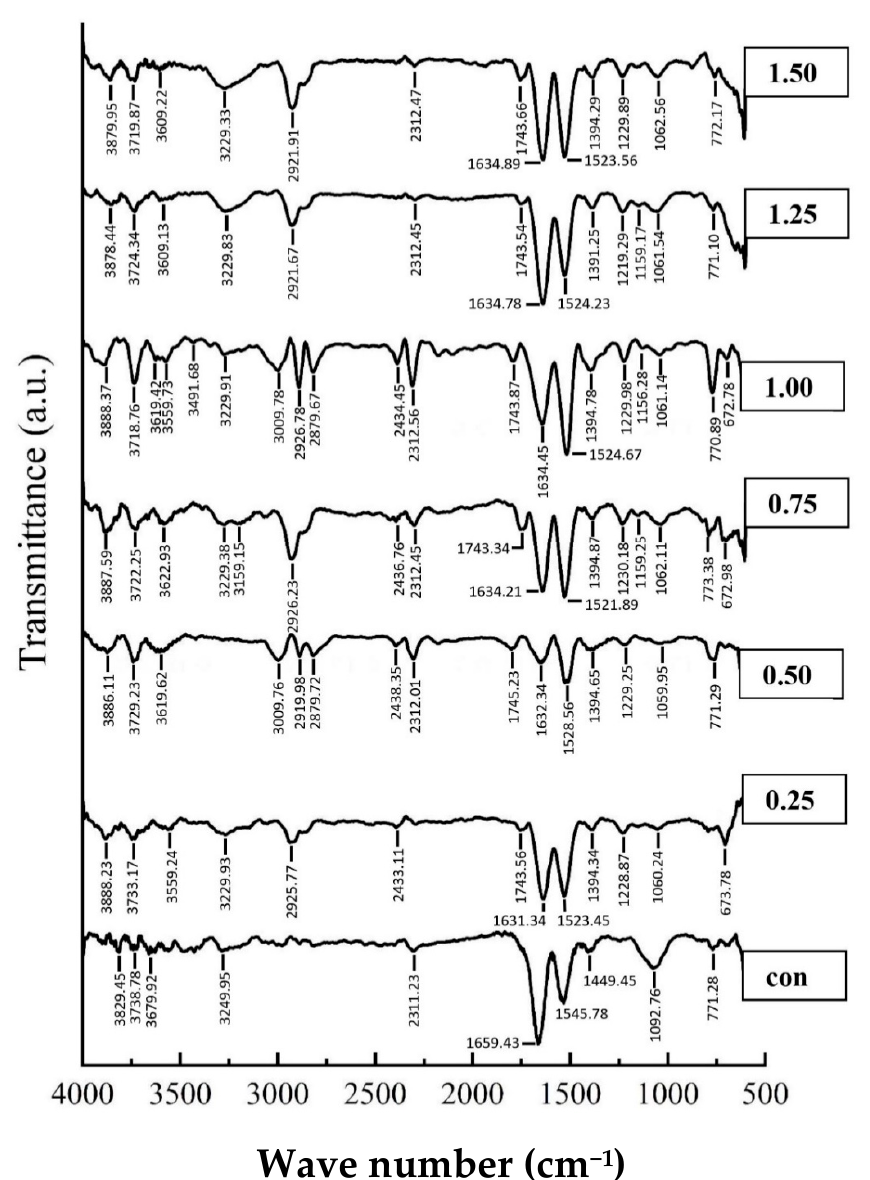
Figure 6. FTIR spectra of silver carp surimi gel with PPE powder added at different concentrations.